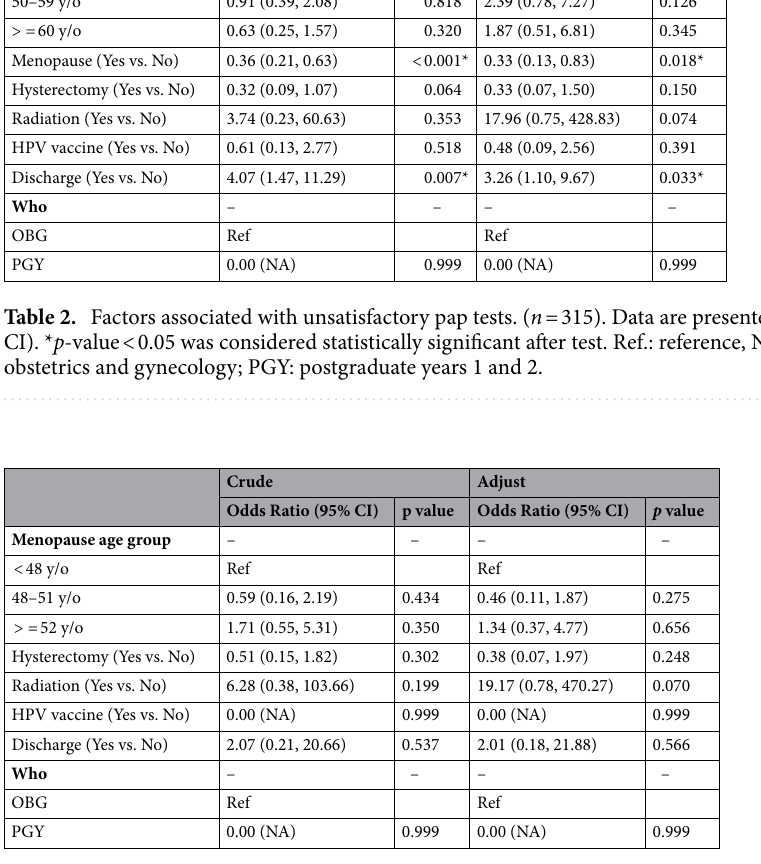
Table 3. Factors associated with no unsatisfactory pap tests among menopause women. ( n = 184). Data are presented as Odds ratio(95% CI). * p -value < 0.05 was considered statistically significant after test. OBG: obstetrics and gynecology; PGY: postgraduate years 1 and 2.